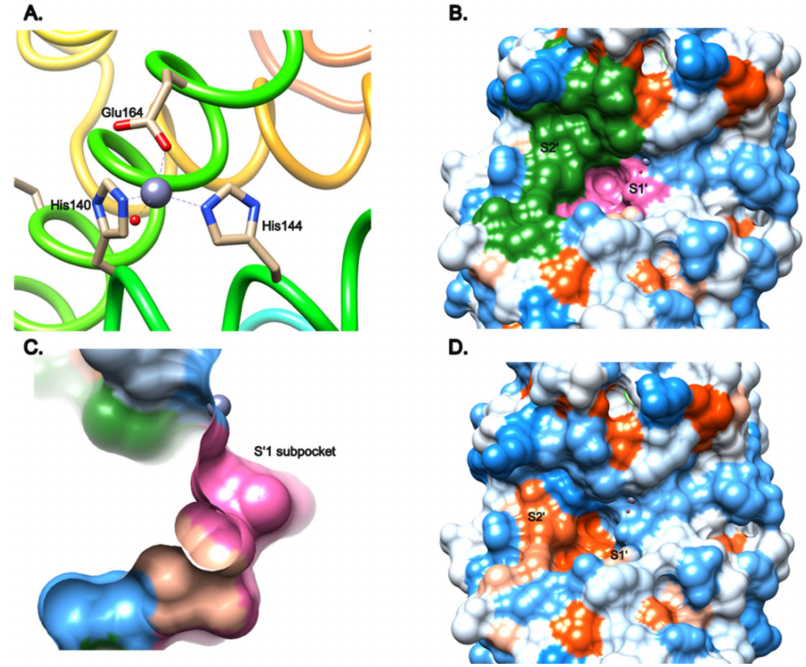
Figure 1. Structural description of the active site of LasB (PDB entry: 1EZM) [34] visualized using Chimera 1.15. ( A ) Tetrahedral coordination of the zinc cation by His140, His144 and Glu164, as well as a water molecule. ( B ) Visualization of the pockets S’1 (pink) and S’2 (green) surfaces. ( C ) Sideview of the deep subpocket of S’1. ( D ) Hydrophobicity of the active-site surface from blue (hydrophilic) to red (hydrophobic). These images were generated using Chimera